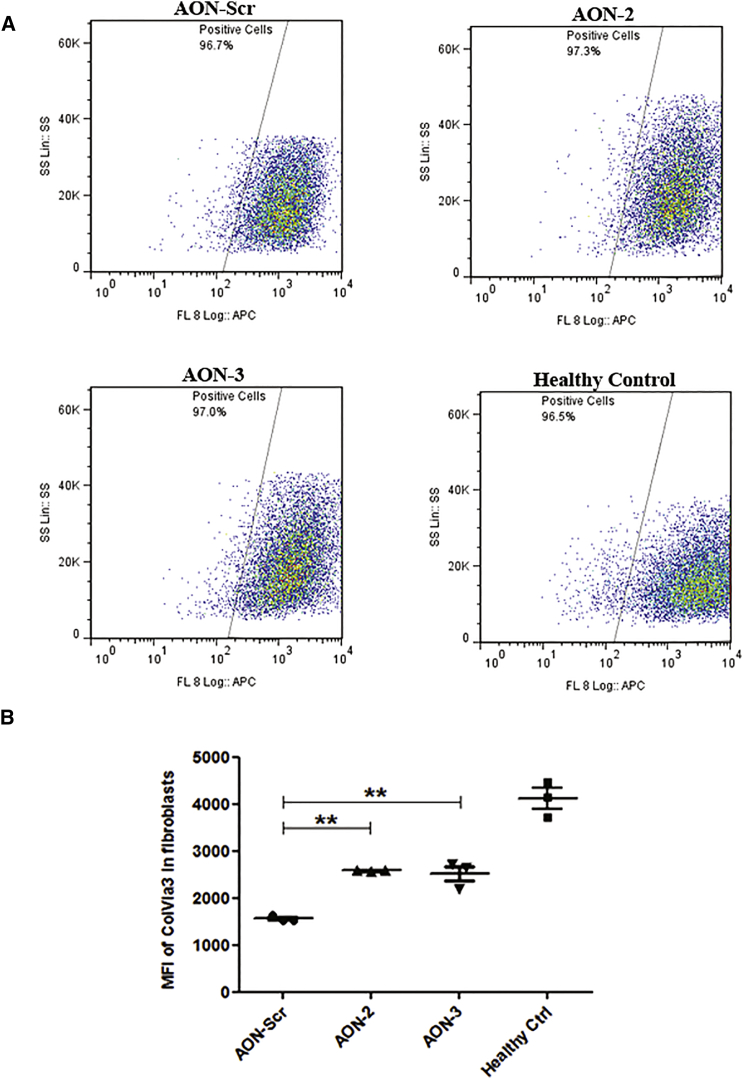
Quantification of ECM Collagen VI α3 Protein in Fibroblasts by Flow Cytometry(A) Representative flow cytometry images of collagen VI α3 analysis. Flow cytometry analysis was performed in patient fibroblasts treated with AON-Scr, AON-2, and AON-3 and healthy control fibroblasts. A total of 10,000 cells were collected and gated using the side scatter on the y axis and fluorescence intensity of collagen VI α3 immunolabeling (FL8 log-APC) on the x axis. (B) The MFI of collagen VI α3 in fibroblasts treated with scrambled control AON (1,558 ± 37.16; n = 3) was dramatically reduced compared to the MFI in healthy control cells (4,107 ± 222.9; n = 3; p < 0.0001). This was significantly increased after AON-2 (2,582 ± 13.58; n = 3) and AON-3 (2,516 ± 160.4; n = 3; **p < 0.01) treatment. Data are presented as mean ± SEM.